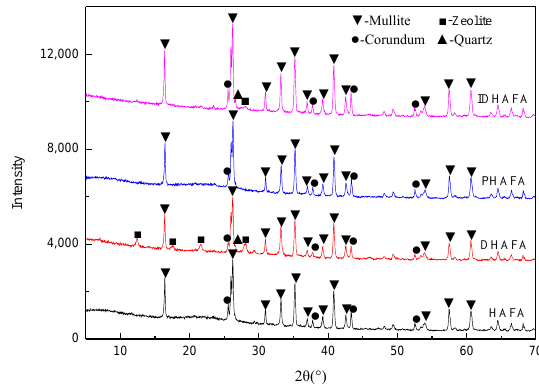
Figure 9. X-ray diffraction (XRD) patterns of HAFA, DHAFA, PHAFA, and IDHAFA.